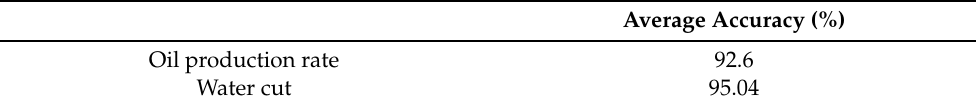
Table 8. Heterogeneous reservoir case 1: average accuracy of oil production rate and water cut for all test samples.